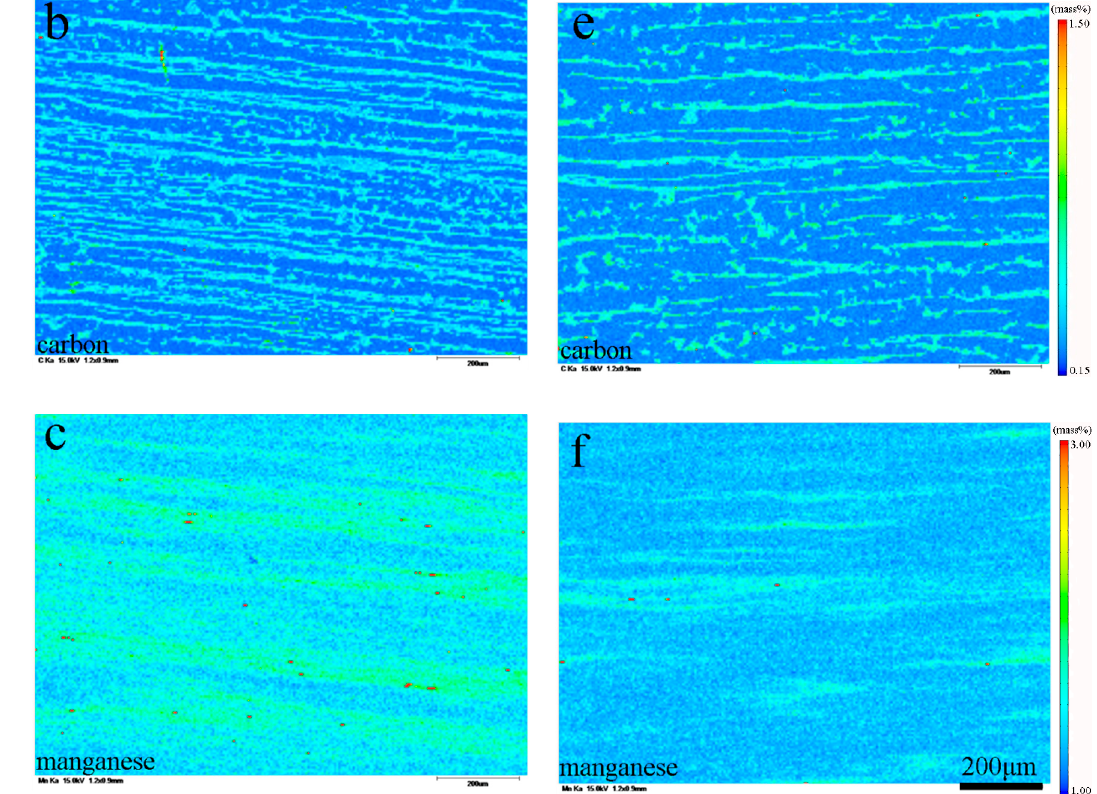
Figure 3. Segregation studies by electron probe micro-analysis (EPMA) mapping in the segregation region of steel: ( a – c ) Steel 1; ( d – f ) Steel 2.